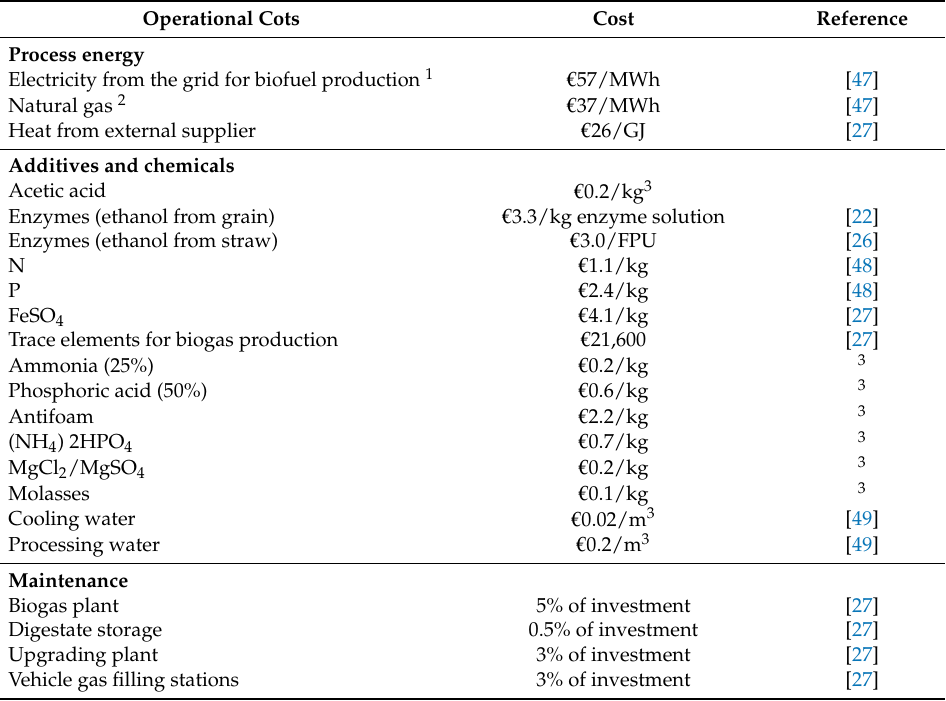
Table A13. Various operational costs associated with the production of biogas and ethanol from wheat grain and